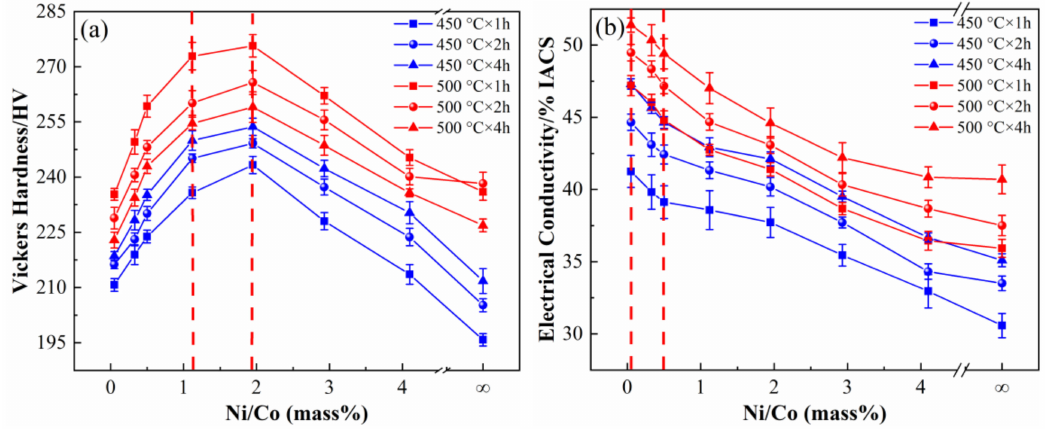
Figure 1. ( a ) Hardness and ( b ) electrical conductivity of alloys aged at 450 ◦ C and 500 ◦ C with di ff erent Ni / Co mass